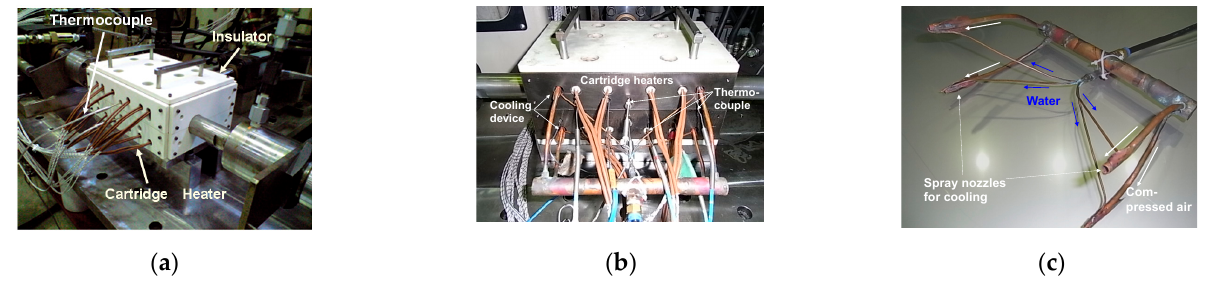
Figure 4. Heating and cooling system for the warm T-shape die. ( a ) For uniform warm temperature field, the entire circumference of the die is surrounded by heat insulator material; ( b ) for non-uniform temperature field; ( c ) cooling device with spray nozzle.